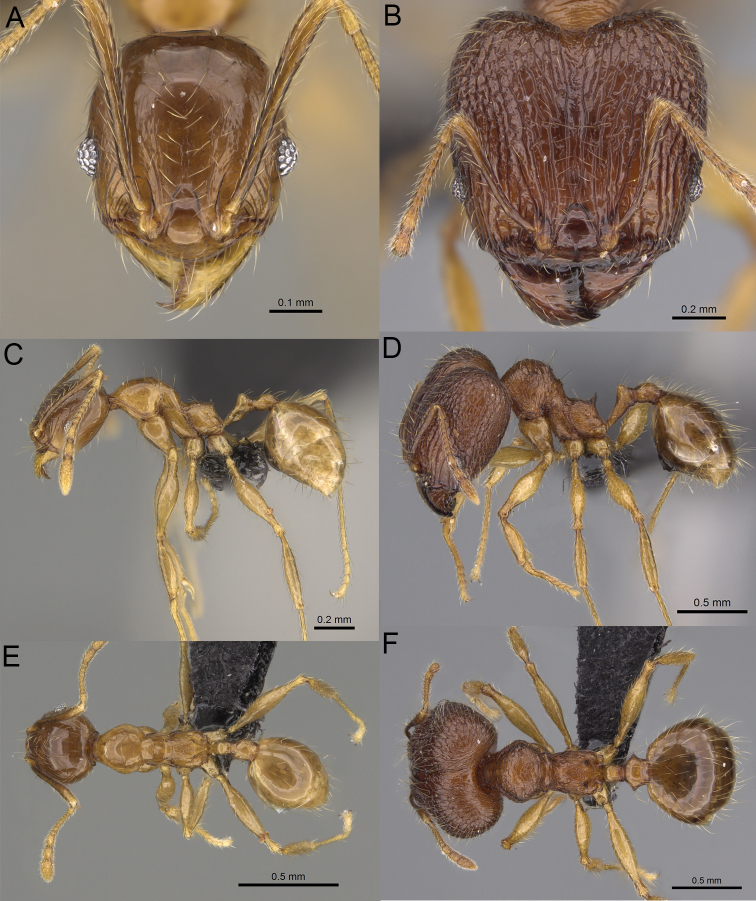
Pheidole
itremo sp. nov., full-face view (A), profile (C), and dorsal view (E) of paratype minor worker (CASENT0491586) and full-face view (B), profile (D), and dorsal view (F) of holotype major worker (CASENT0491584).